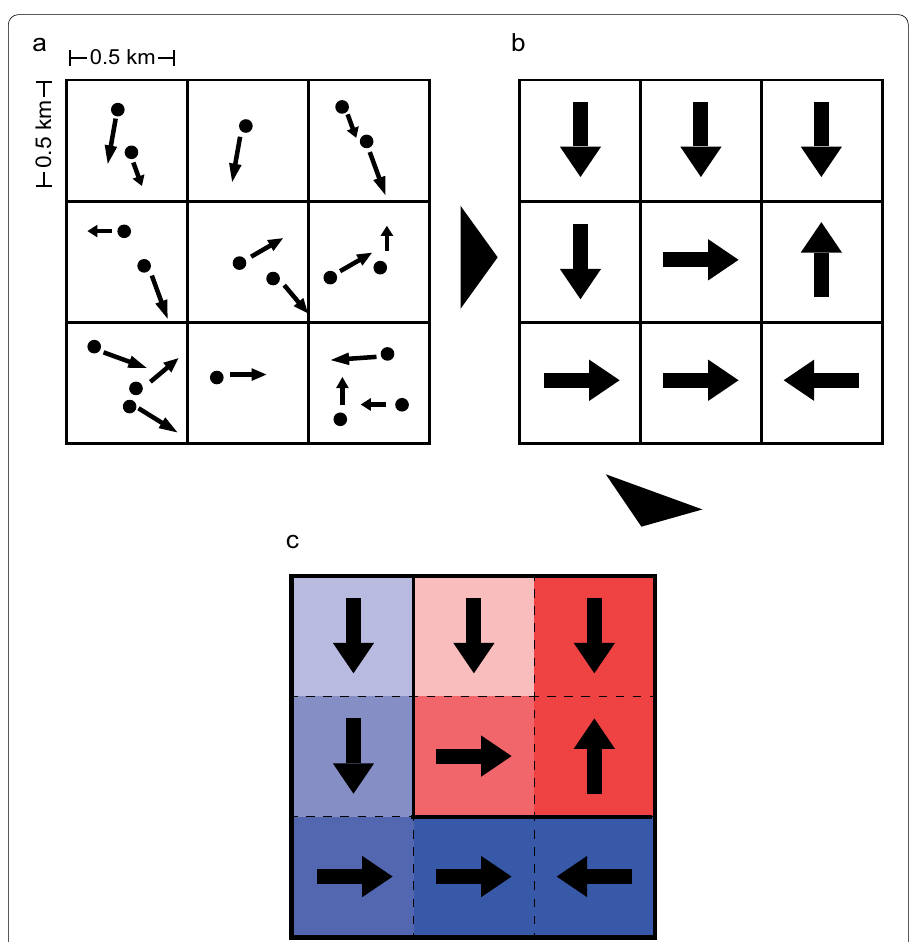
Fig. 2 Velocity discretization and The definition of Drainage basins. a , The mean velocity in each square of 500 × 500m 2 is calculated by average velocity over those moving people in the square every 30 min. However, if no one is moving in the square, it is considered missing and not be calculated. b , The average velocity of each square is discretized in 4 directions (north, east, south, west) according to the angle. c , Each square is connected to an adjacent square according to the direction of the arrow. Connected squares are considered to belong to a drainage basin. There are 2 drainage basins in this figure, red and blue, where the color intensity is proportional to the number of upstream